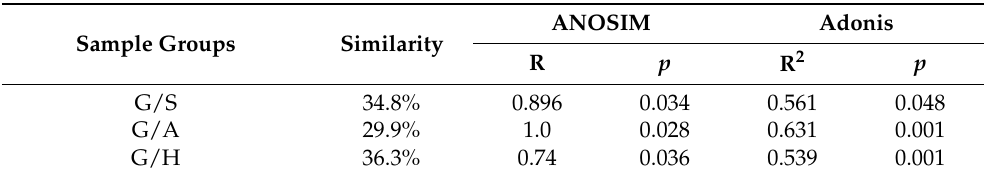
Figure 1. The α -diversity indices of the microbial composition in the worm intestine and different sediments from a Sipunculus nudus aquaculture area. ( A ) Number of observed OTUs. ( B ) Shannon diversity index. ( C ) Chao1 index. Asterisks (*) indicate significant differences ( p < 0.05, Wilcoxon